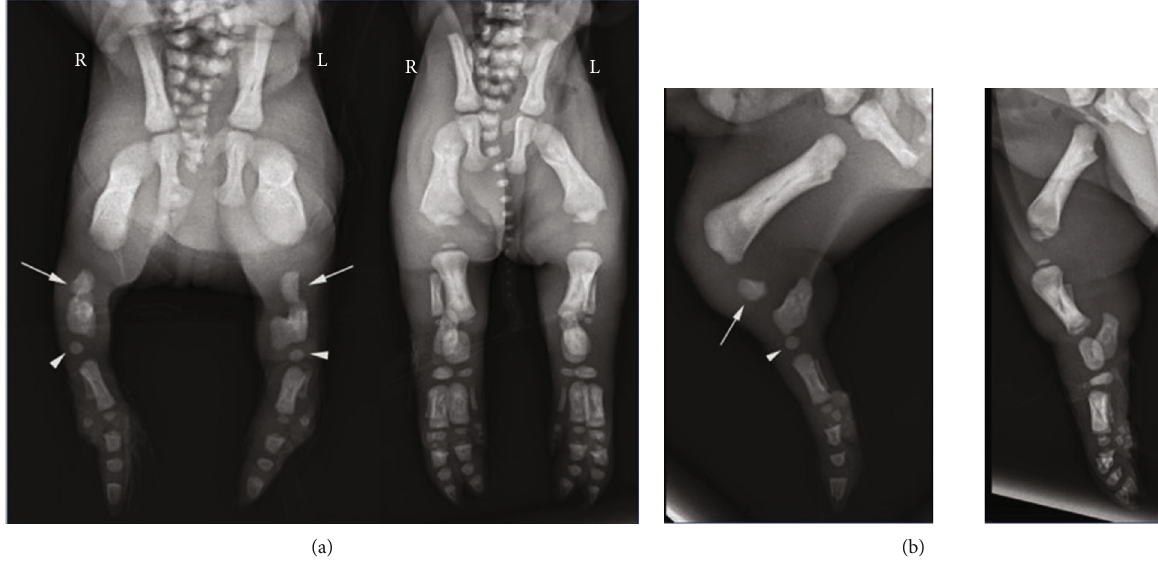
Figure 2: Comparative radiographs of pig #1 with syndactyly (left) and pig #2 with normal fi ndings (right) illustrate the single digit fully developed in pig #1. Note also the markedly shortened tibias with absent fi bulas (arrows) and underdeveloped tarsal cuboid bones (arrowheads): (a) craniocaudal projection; (b) mediolateral